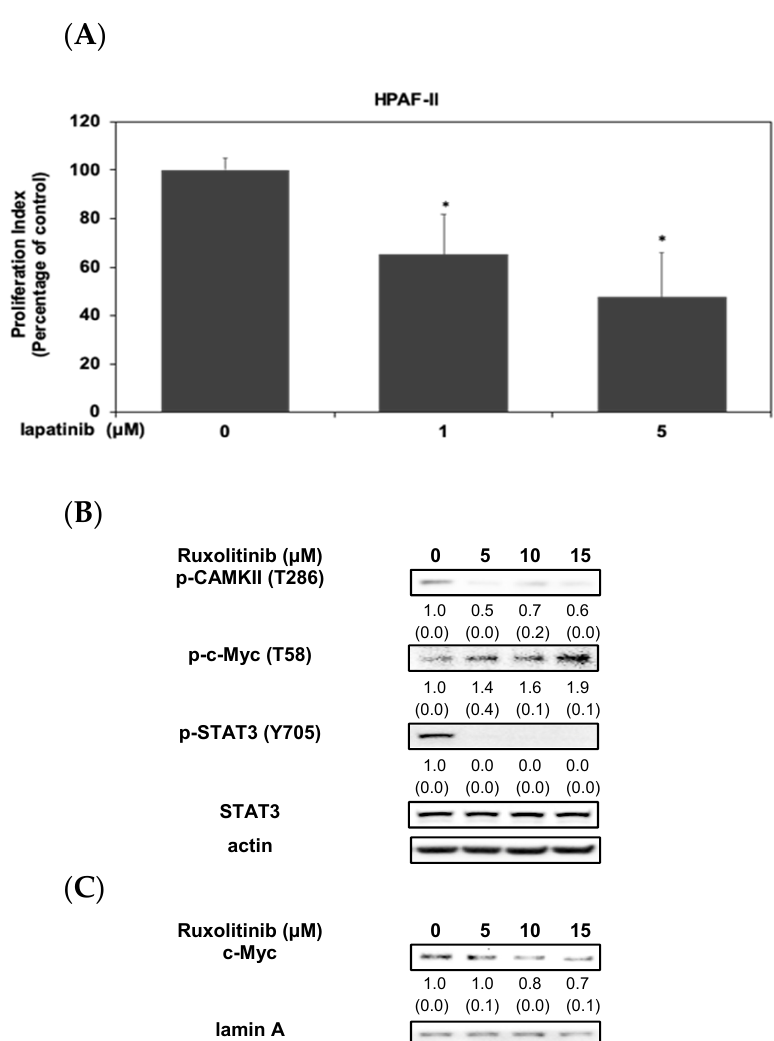
Figure 2. Activation of STAT3/CAMKII signaling pathway is involved in the phosphorylation and expression of c-Myc protein in HPAF-II cells. ( A ) Human PDAC HPAF-II cells were treated with lapatinib (at concentrations of 1 and 5 µ M), a specific inhibitor of EGFR, in 10% FBS DMEM containing 25 mM glucose for 24 h. Cell proliferation was analyzed using MTT assay as described in Materials and Methods Section. Statistical significance is expressed as the mean ± SD (standard deviation) of three independent experiments. An asterisk (*) represent statistically significant differences in comparison with the control subgroup ( p < 0.05). Human PDAC HPAF-II cells were treated with ruxolitinib (at concentrations of 5, 10 and 15 µ M), a specific inhibitor of JAK/STAT3 signaling pathway, in 10% FBS DMEM for 24 h. Western blotting analysis of cytoplasmic ( B ) and nuclear proteins ( C ) (at 24 h time point) was performed using antibodies against p-CAMKII (T286), p-c-Myc (T58), p-STAT3 (Y705), STAT3, c-Myc, actin and lamin A. Band intensities represent as the mean ± SD (within parenthesis) for the amount of cytoplasmic and nuclear proteins in comparison with corresponding control proteins, including STAT3 (internal control for p- STAT3), actin and lamin A,